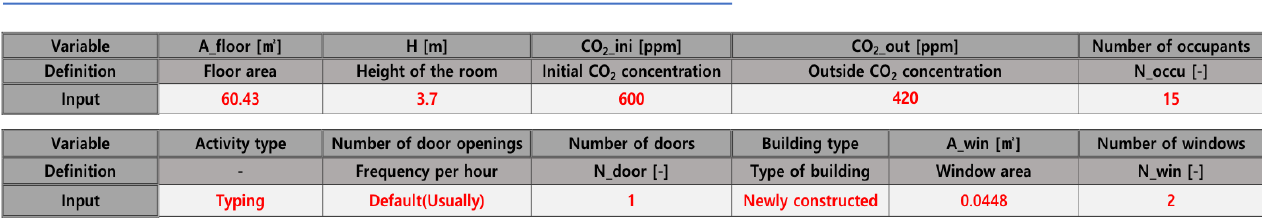
Figure 17. CO 2 concentration prediction system input example of Office Space B.